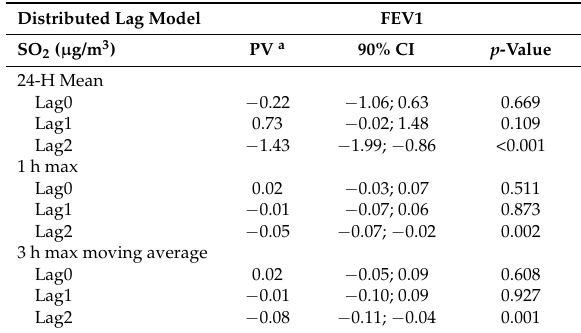
Table 5. Distributed lag models in the Panel 20 study. Percent variation (PV) and 90%